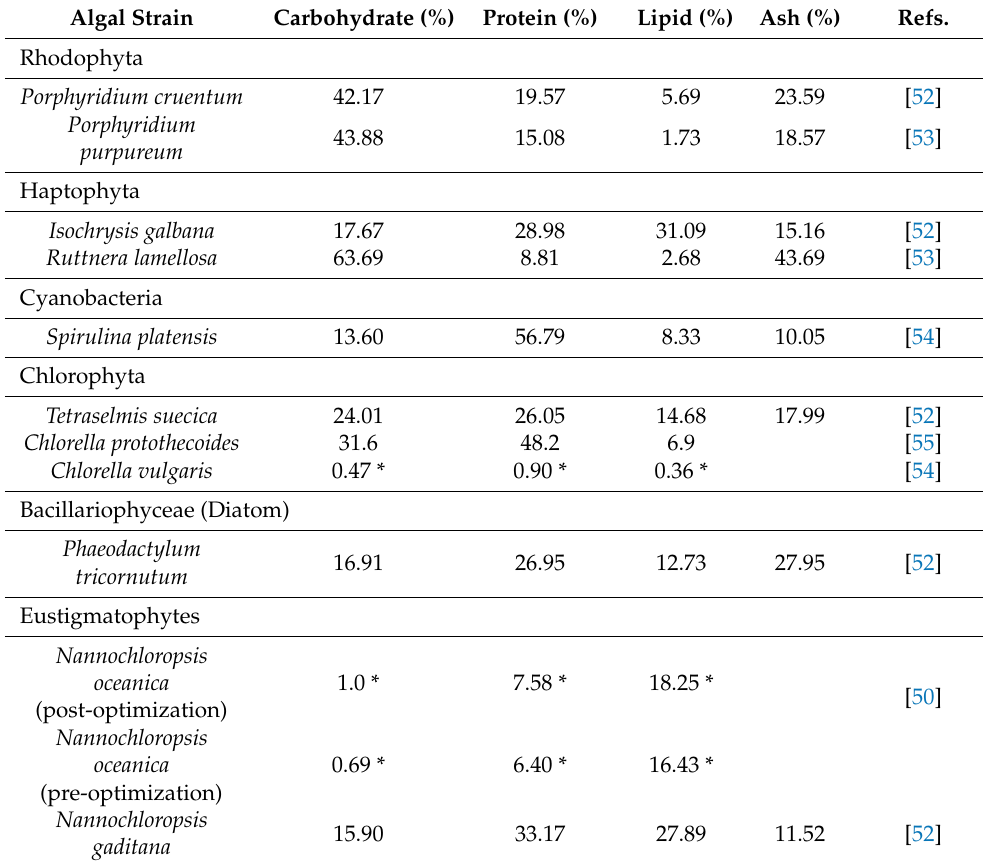
Table 2. Chemical composition of various microalgae containing sulfated polysaccharides. Algal Strain Carbohydrate (%) Protein (%) Lipid (%) Ash (%) Refs.